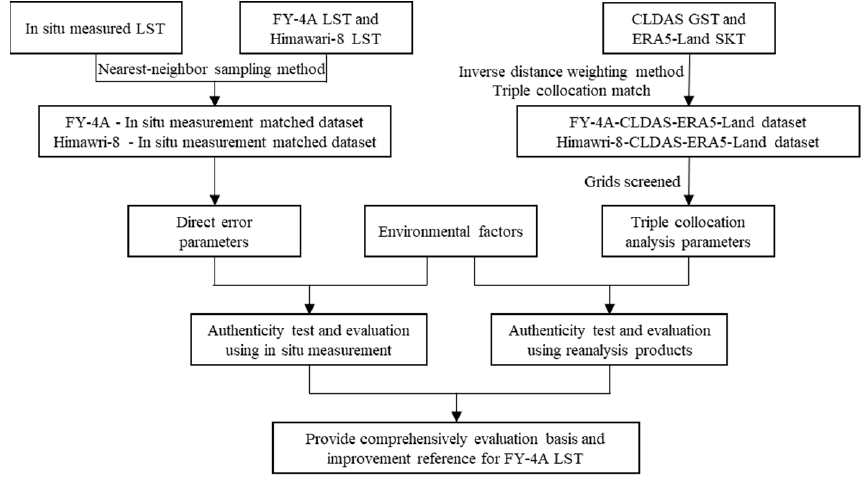
Figure 2. Flowchart of this research project.